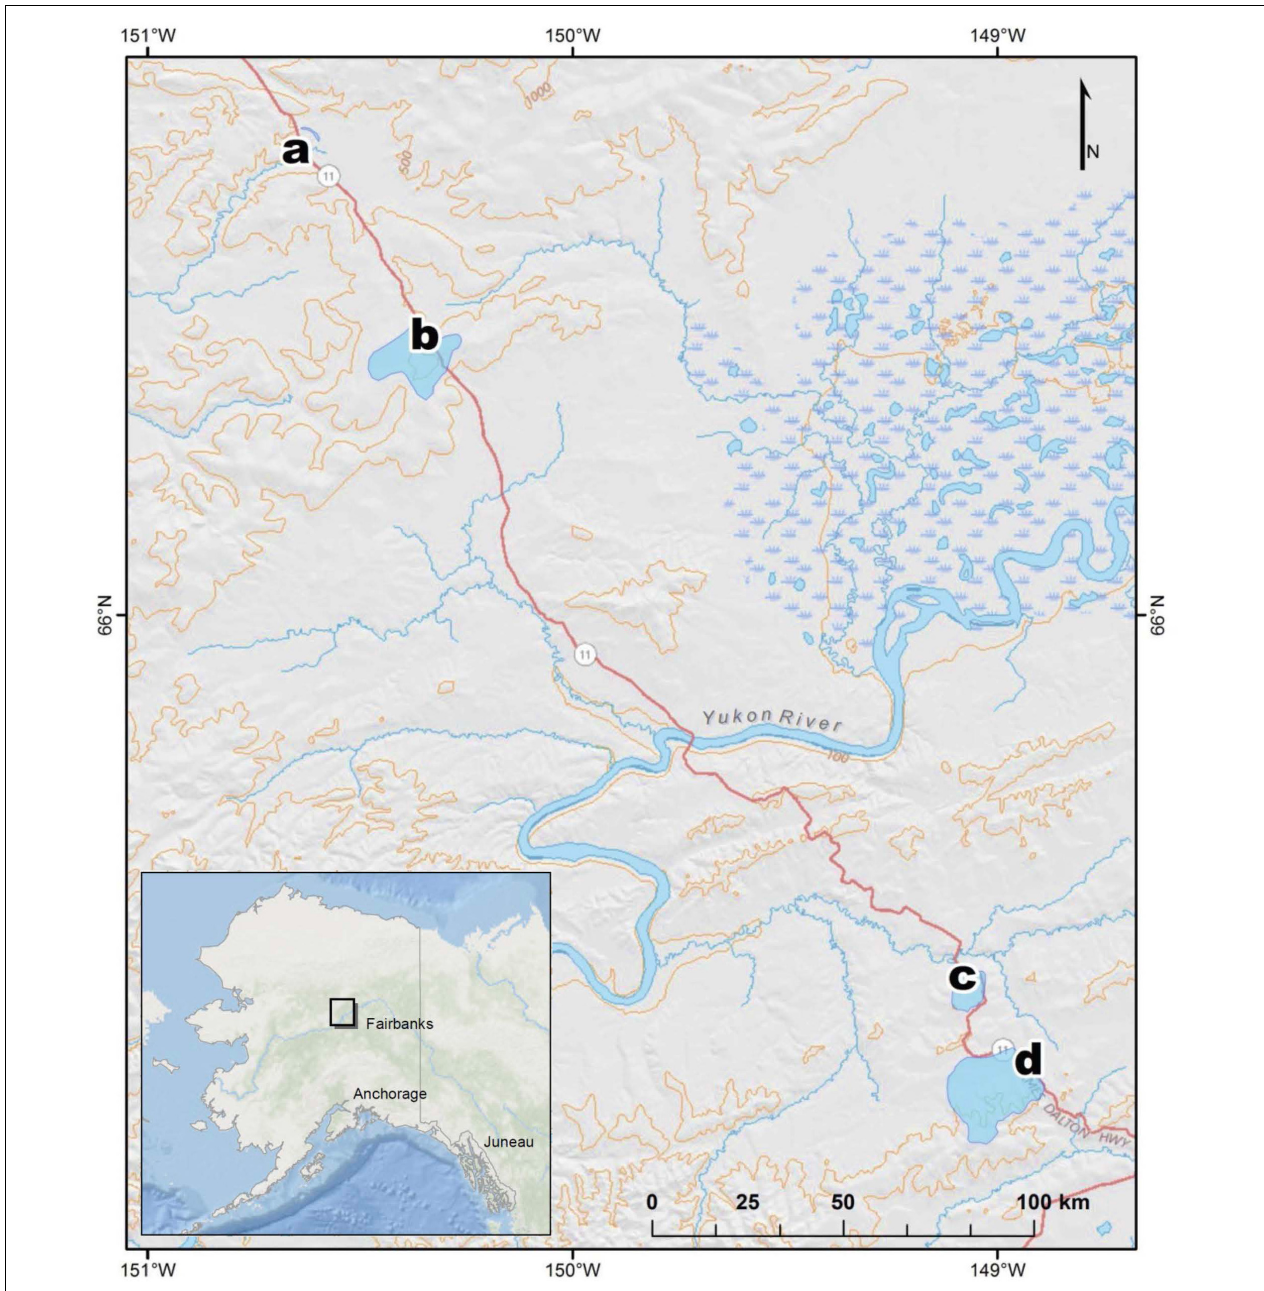
FIGURE 1 | Map of stream sampling site locations and watersheds in Interior Alaska, United States, at (a) Old Man, (b) West Fork Dall, (c) Richardson, and (d) Erickson